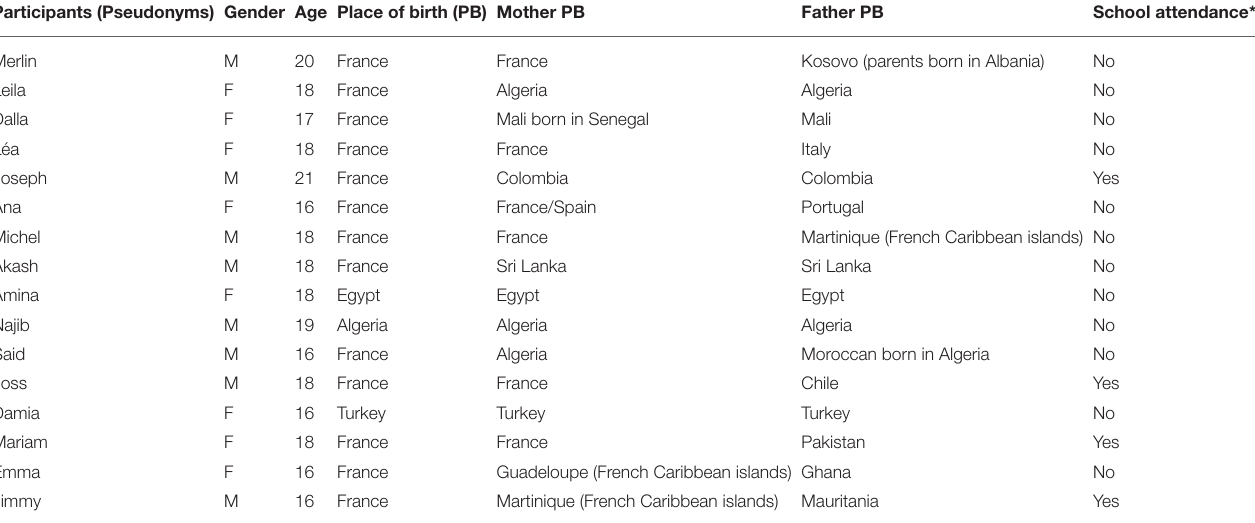
TABLE 1 | Characteristics of the population.